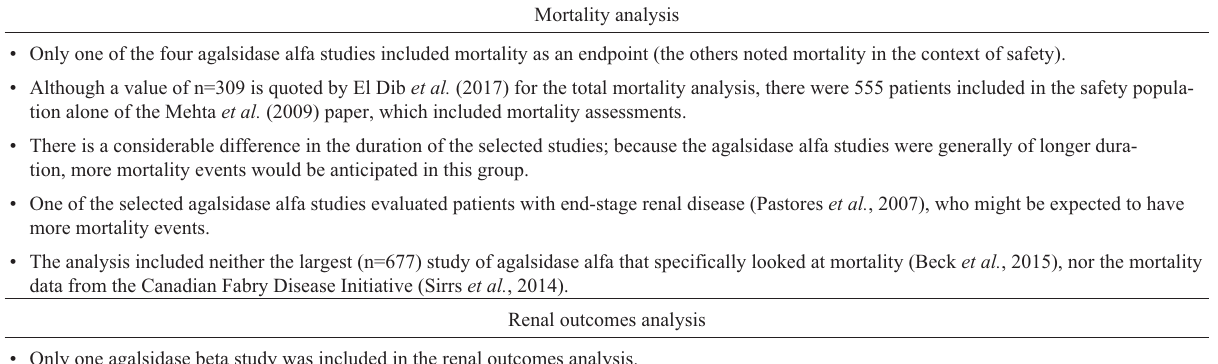
Table 1 - Specific comments relating to outcome measures described in the 2017 analysis by El Dib and